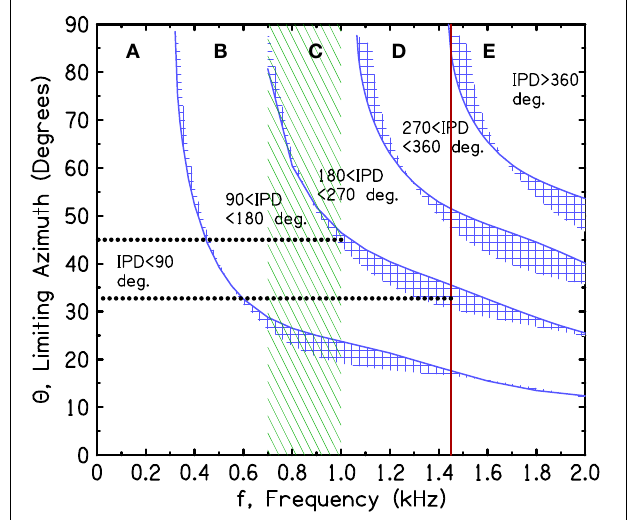
FIGURE 7 | Sensitivity regions from Figure 6 together with model boundaries for the IPD regions from Figure 3. The dotted lines refer to the argument in the text against the ecological interpretation given present-day human head